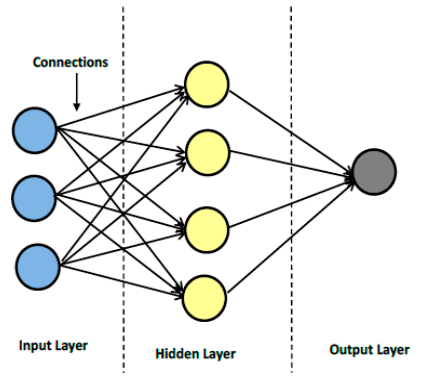
Figure 7. Generic diagram of an ANN network .